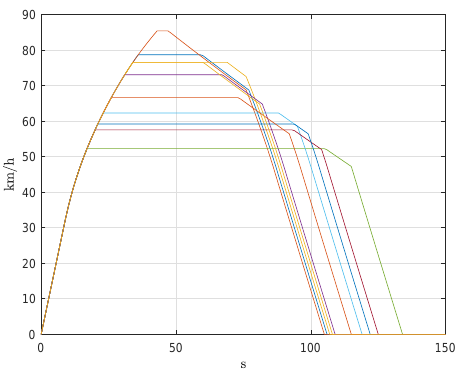
Figure 5. OSP generated without speed constraints.